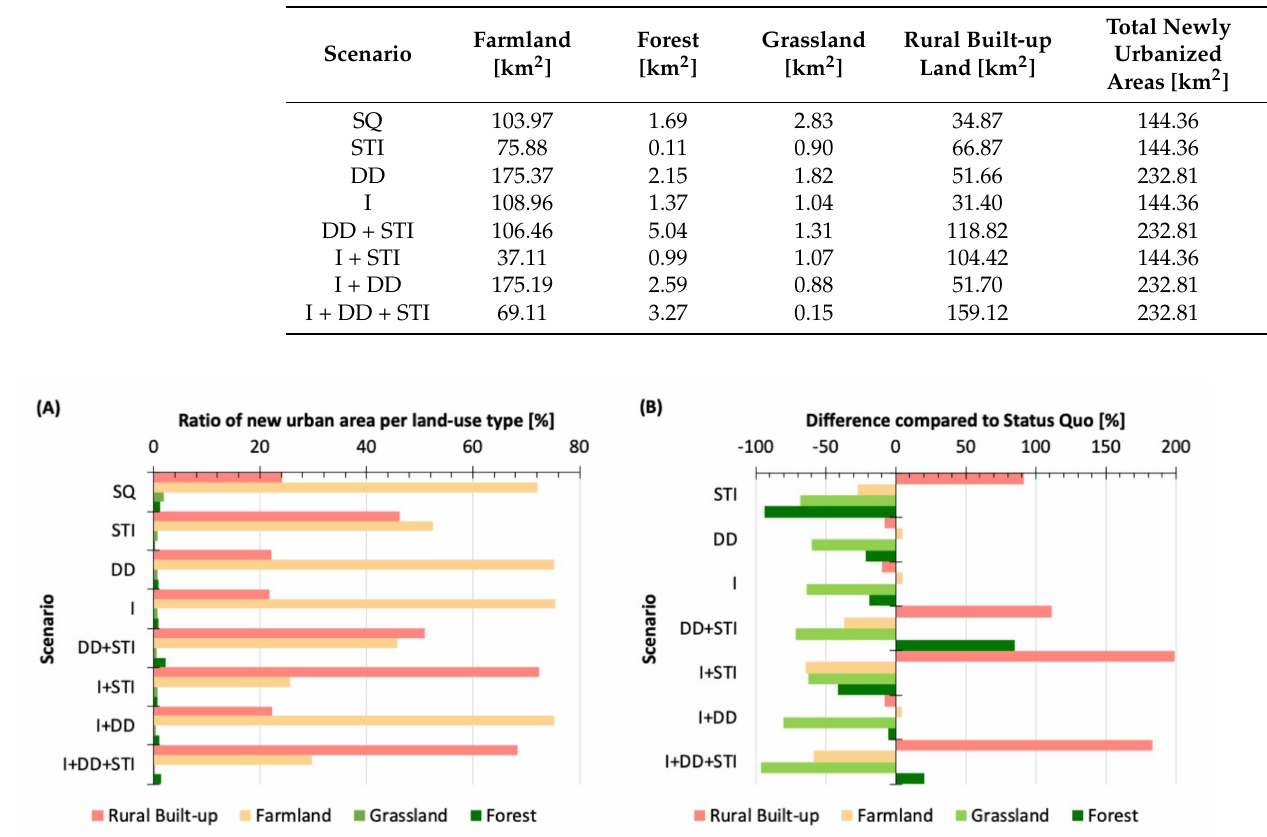
Figure 4. Scenario comparisons of newly developed urban areas: ( A ) ratio of new urban areas located on former land-use types, and ( B ) difference of land-use types in the landscape as compared to the Status Quo Scenario.